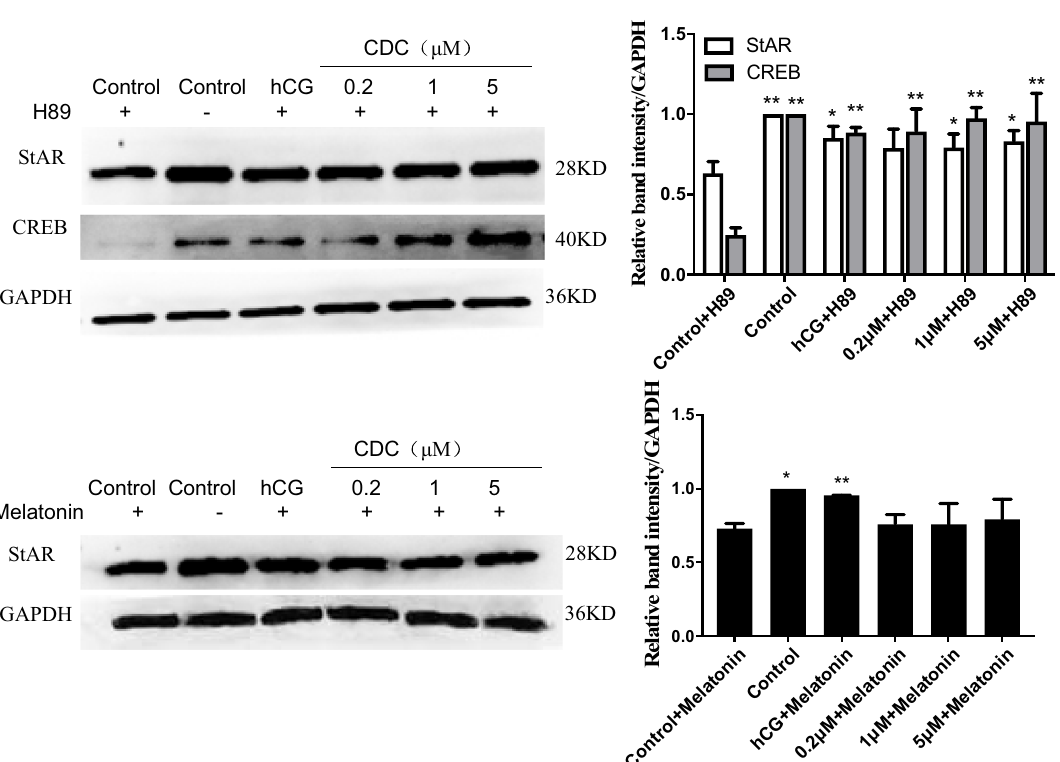
Figure 4. Effect of β-cyclodextrin–curcumin on the protein expression of NR5A1, CREB, StAR, and 3β-HSD in Leydig cells. * P < 0.05, ** P < 0.01 respect to Control. CDC β-CD-cucurmin.